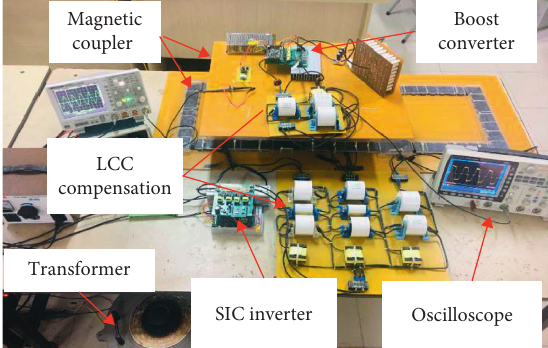
Figure 9: The DWC system experimental setup.